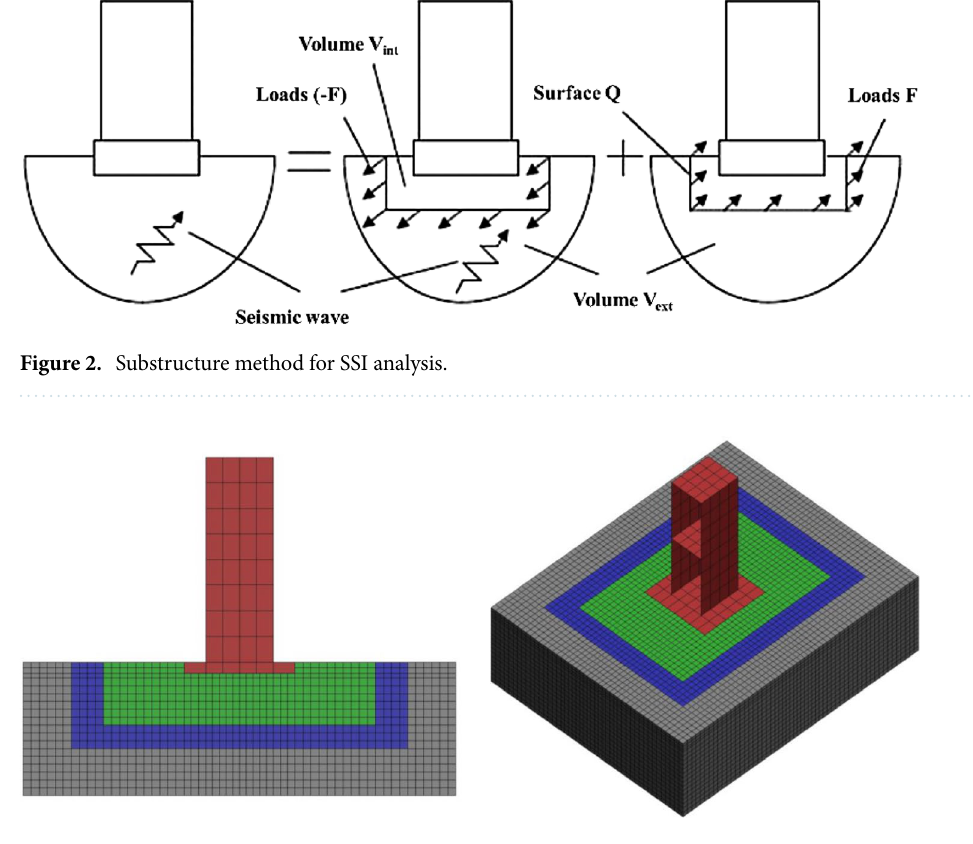
Figure 3. Direct method for SSI analysis 30